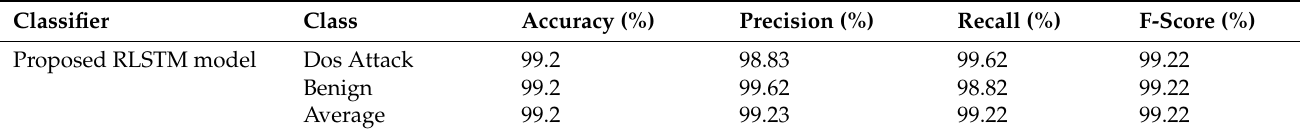
Table 5. Results of CICIDS-2017.